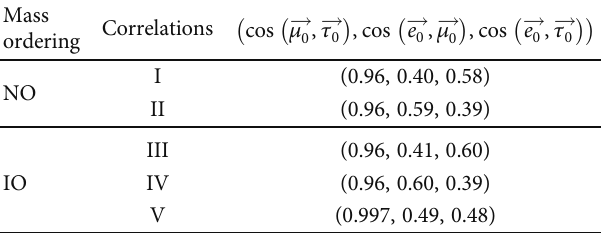
Table 5: Representative correlations of three included